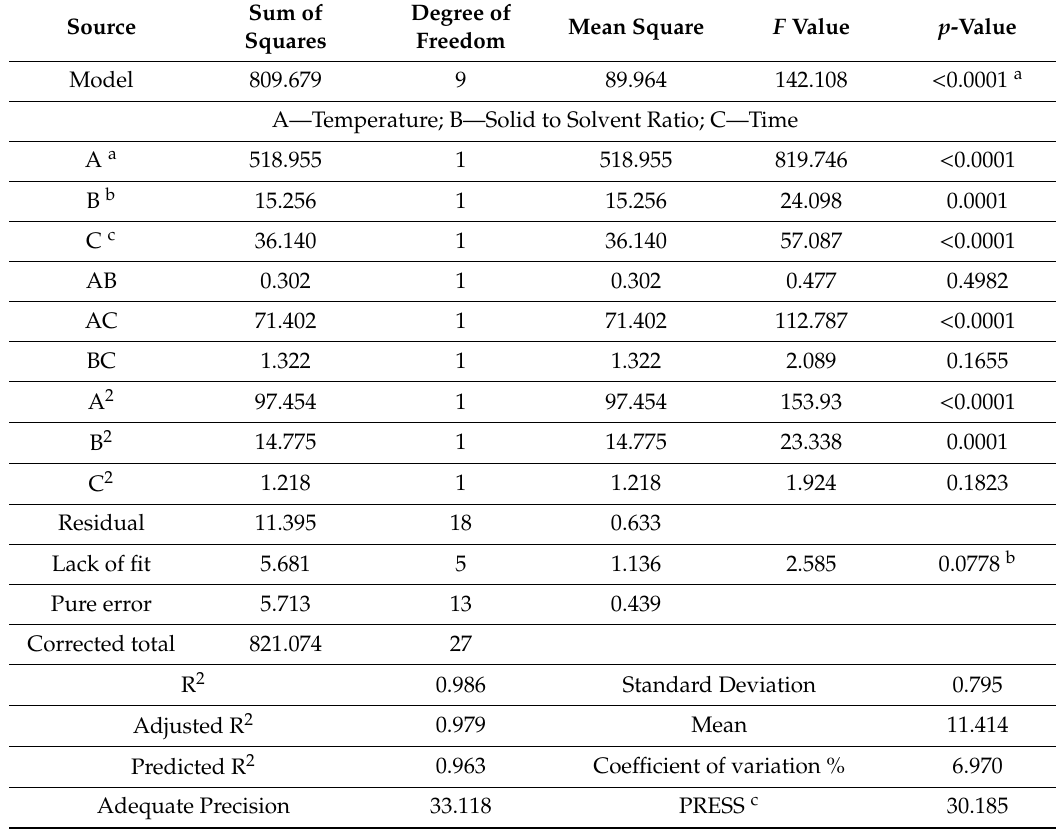
Table 3. ANOVA and regression coe ffi cient for the reduced quadratic